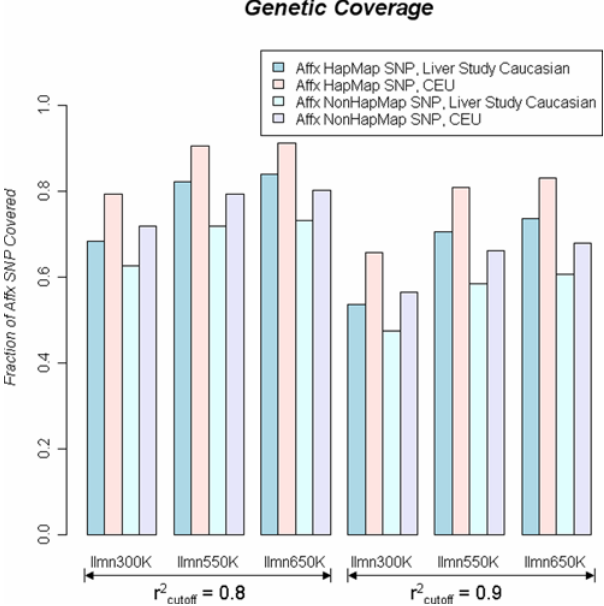
Figure 1. Plot of genetic coverage of Affx HapMap SNPs and Affx NonHapMap SNPs were calculated among HapMap CEU subjects and liver study subjects, respectively. The effect of SNP overfitting and sample overfitting can be